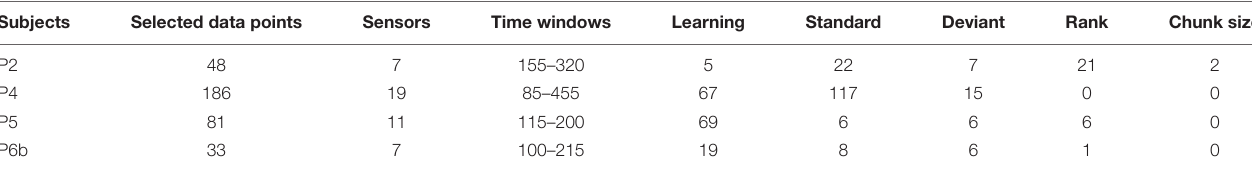
TABLE 3 | Selection of data points for the Predictability analysis. Subjects Selected data points